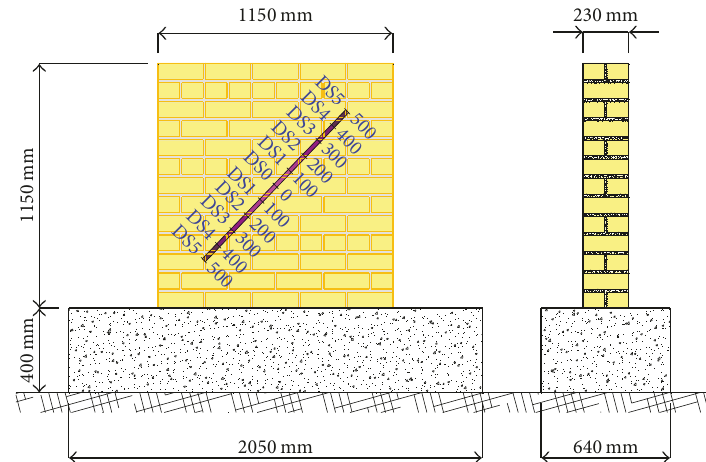
Figure 1: Specimen dimensions and damage distribution at different DS.